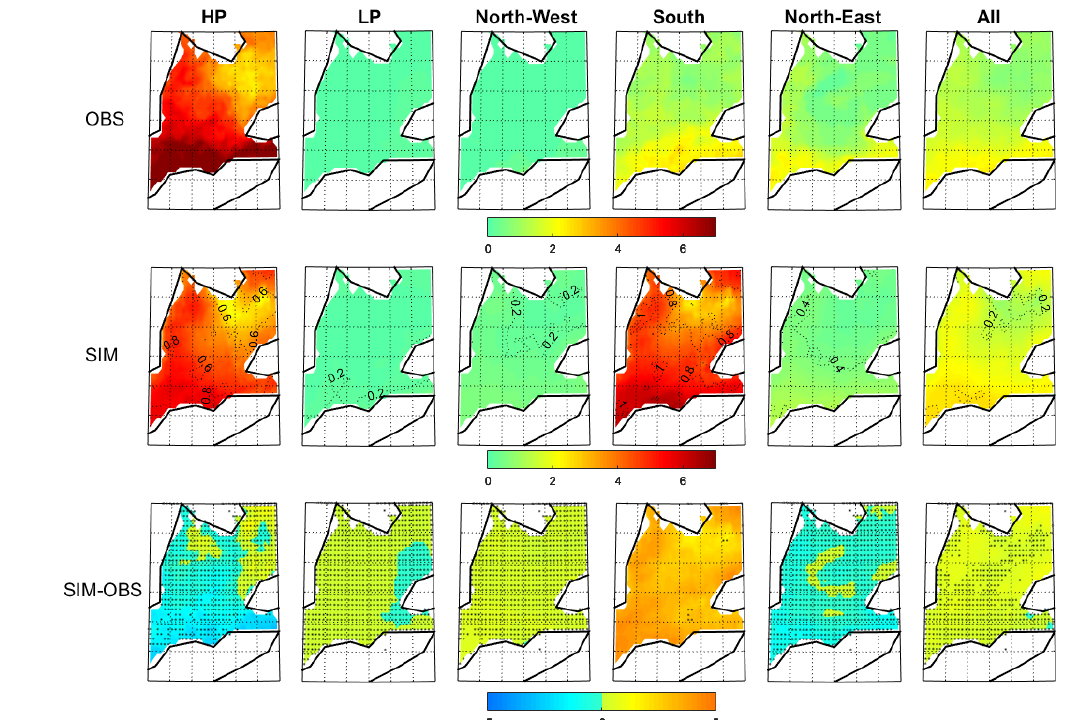
Figure 6. Percentage of DJF number of heavy rain and warm events ( P > 10mm and T > 5 ◦ C) relative to DJF occurrence of weather regimes in the historical period (1961–1990) for the observations (upper panels), simulations from CRCM5-LE 50-member average (middle panels) and observations minus simulations (lower panels). The dotted lines in the middle panels represent the standard deviation of the 50- member CRCM5-LE simulated percentage. Stippled regions in the lower panels indicate where the observations lie within the CRCM5-LE ensemble